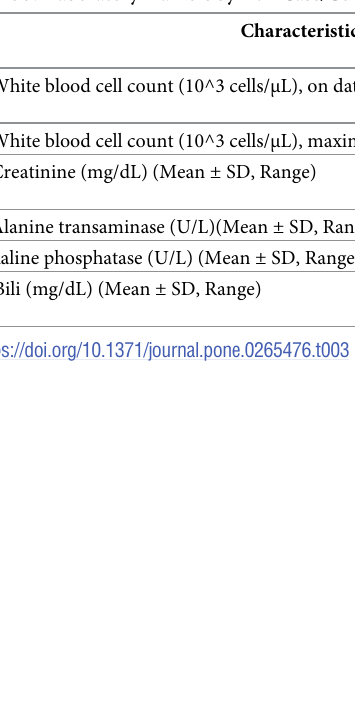
Table 3. Laboratory markers by PVL Case/Control Status.